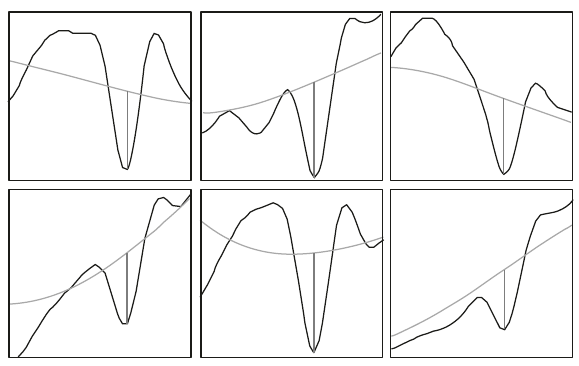
Figure 6: Positioning of an interference peak from an ECG triggering point: some examples.